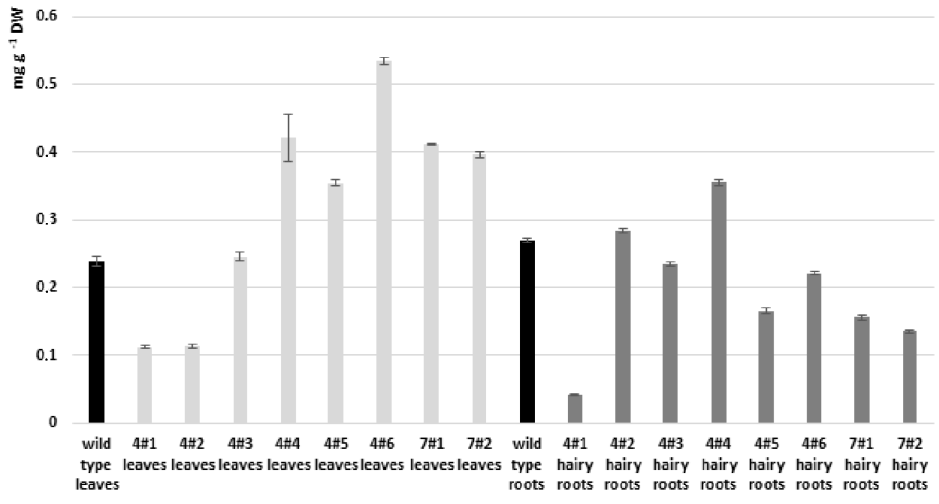
Figure 5. Betulinic acid content measured in the composite plants S. purpurea and in the investigated hairy roots by HPLC as described in Section 2. The data ( ± SD) were obtained from three samples per